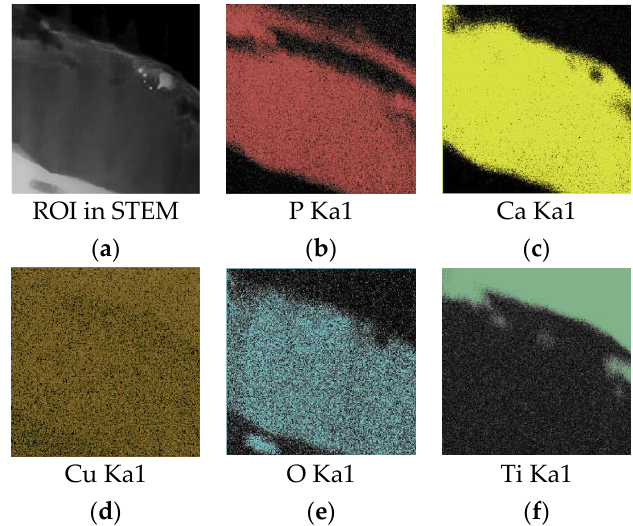
Figure 8. An energy dispersive X-ray (EDX) element mapping of the Cu-HA and Ti substrate in TEM lamella. ( a ) ROI in STEM; ( b ) P Ka1; ( c ) Ca Ka1; ( d ) Cu Ka1; ( e ) O Ka1; ( f ) Ti Ka1. Table 2. Elemental composition of the Cu-HA coating after HT at 700 ◦ C. Elemental Composition Region of Detection